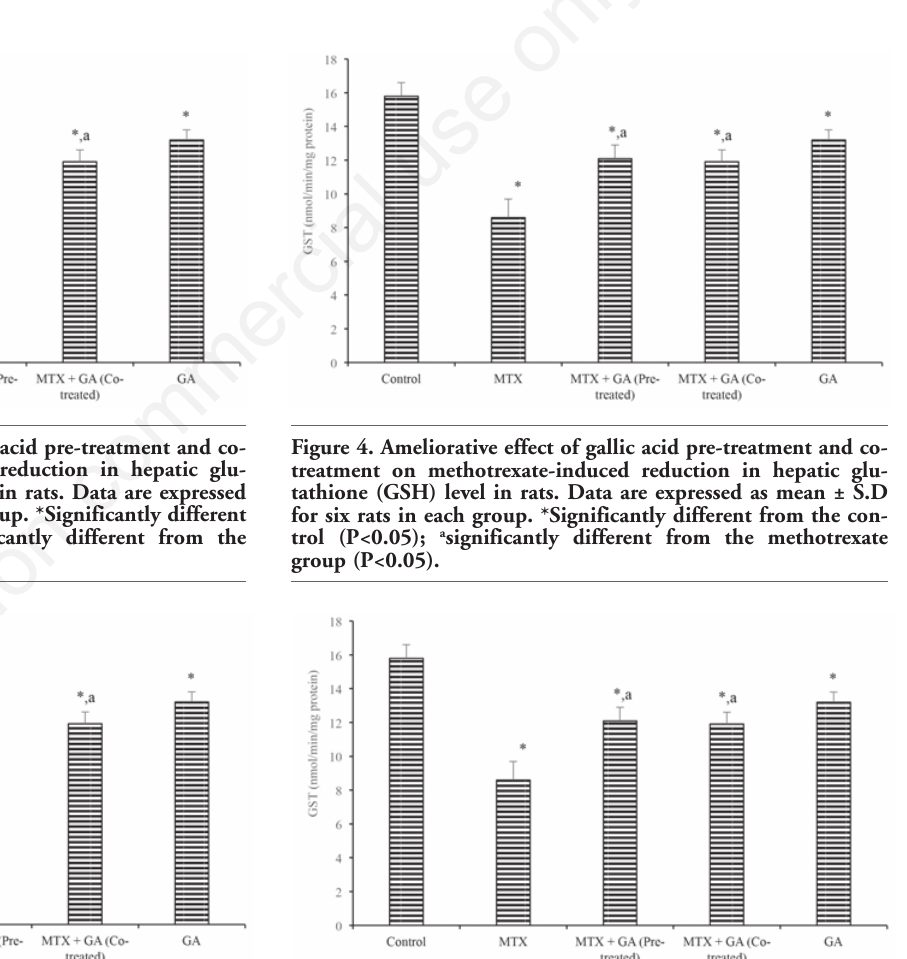
Figure 1. Chemical structure of methotrex- ate (A) and gallic acid (B).